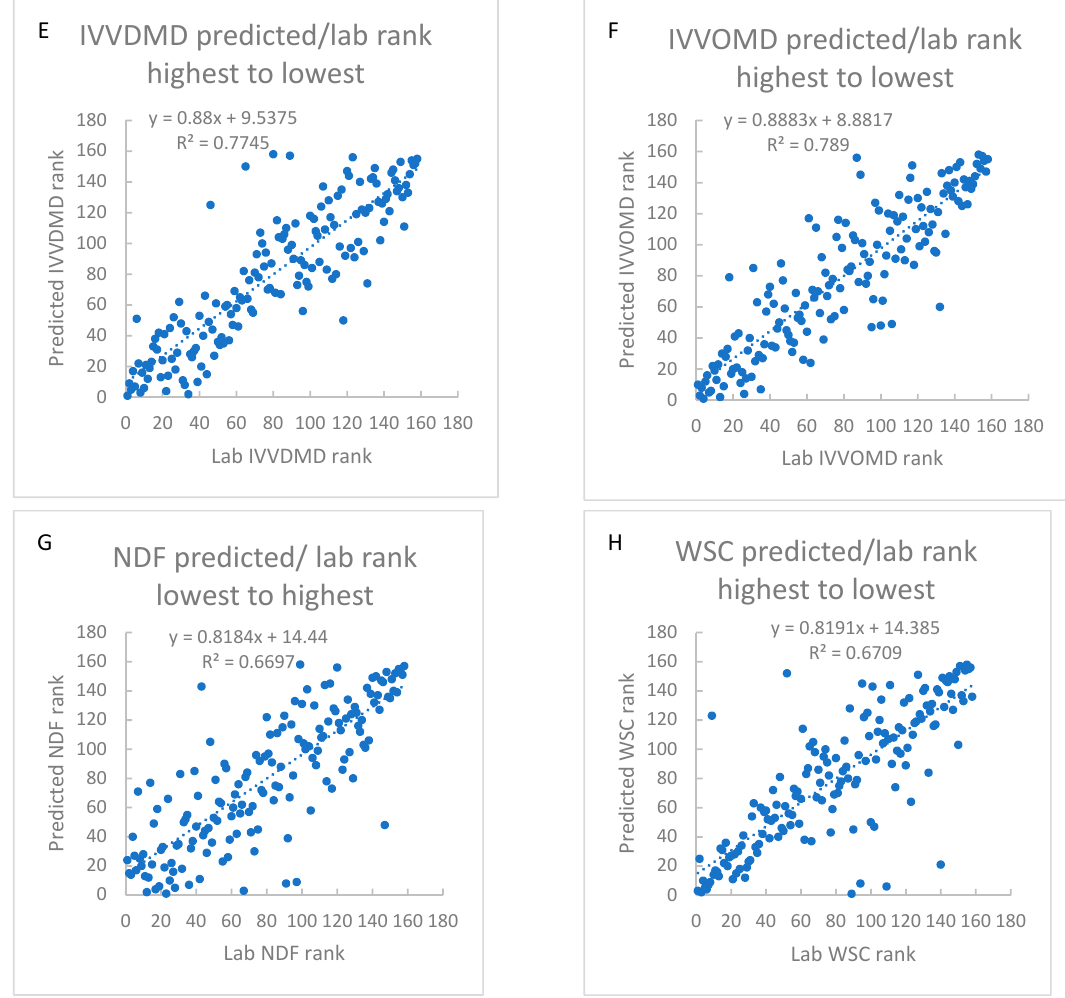
Figure 3. ( A ) compares the ADF rankings of 159 plants determined by the model to the rankings determined by lab analysis with R 2 of 0.7878. ( B ) compares the ash rankings of 159 plants determined by the model to the rankings determined by lab analysis with R 2 of 0.8511. ( C ) compares the CP rankings of 159 plants determined by the model to the rankings determined by lab analysis with R 2 of 0.8678. ( D ) compares the DM rankings of 159 plants determined by the model to the rankings determined by weighing the plants before and after drying with R 2 of 0.3916. ( E ) compares the IVVDMD rankings of 159 plants determined by the model to the rankings determined by lab analysis with R 2 of 0.7745. ( F ) compares the IVVOMD rankings of 159 plants determined by the model to the rankings determined by lab analysis with R 2 of 0.789. ( G ) compares the NDF rankings of 159 plants determined by the model to the rankings determined by lab analysis with R 2 of 0.6697. ( H ) compares the WSC rankings of 159 plants determined by the model to the rankings determined by lab analysis with R 2 of 0.6709.